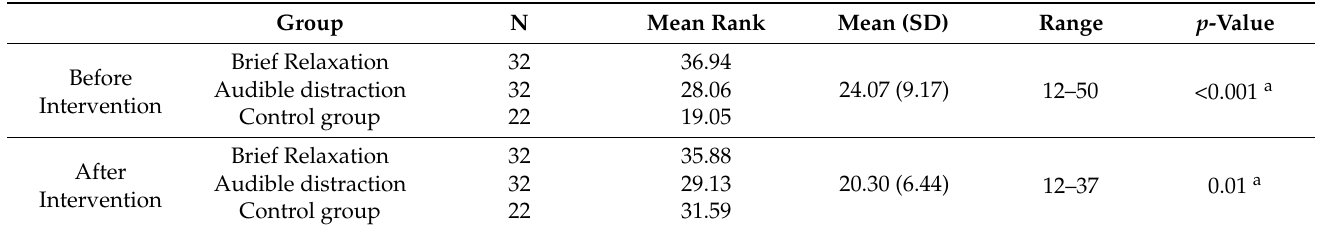
Table 1. Difference in the anxiety level between the three groups before and after the interventions. Group Before